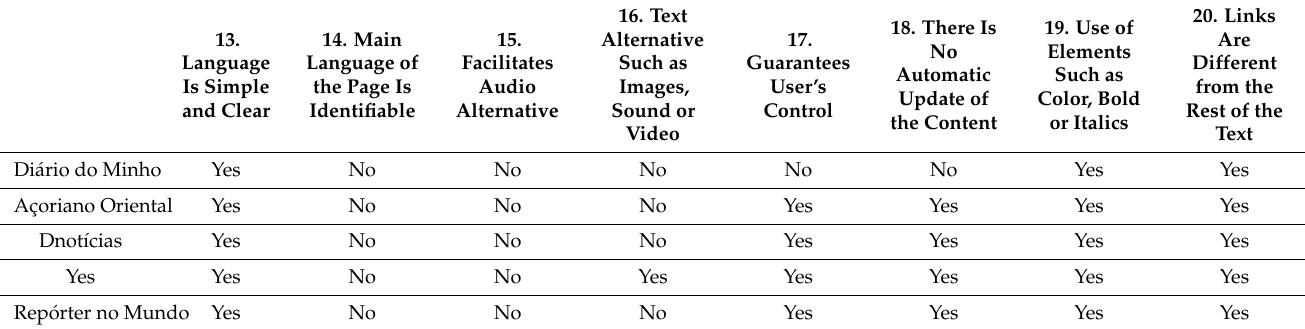
Table 5. Results of the evaluation of the content of Portuguese